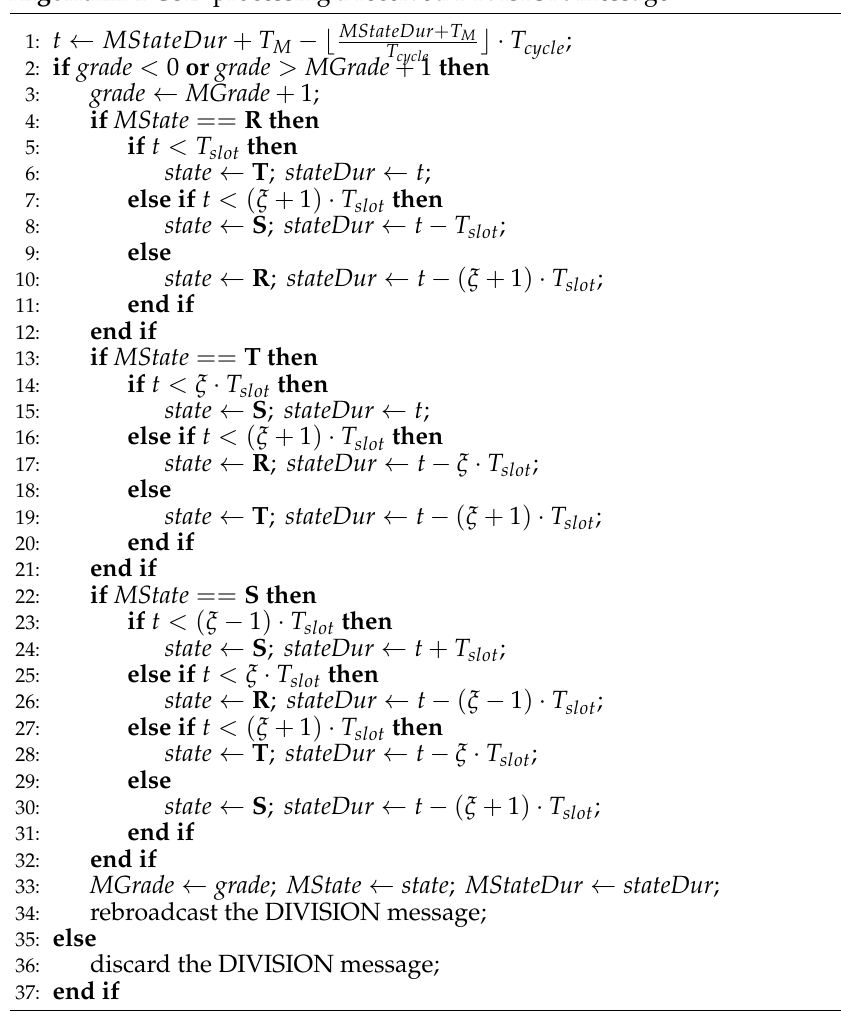
Algorithm 1 GSE: processing a received DIVISION